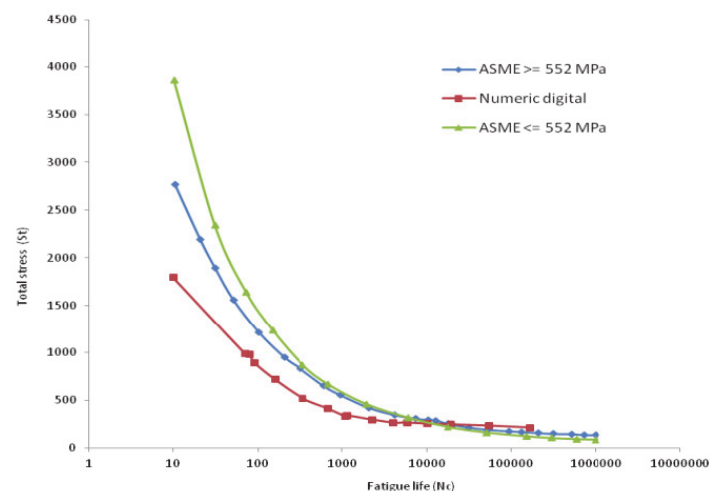
Figure 7: Cycle life of expansion